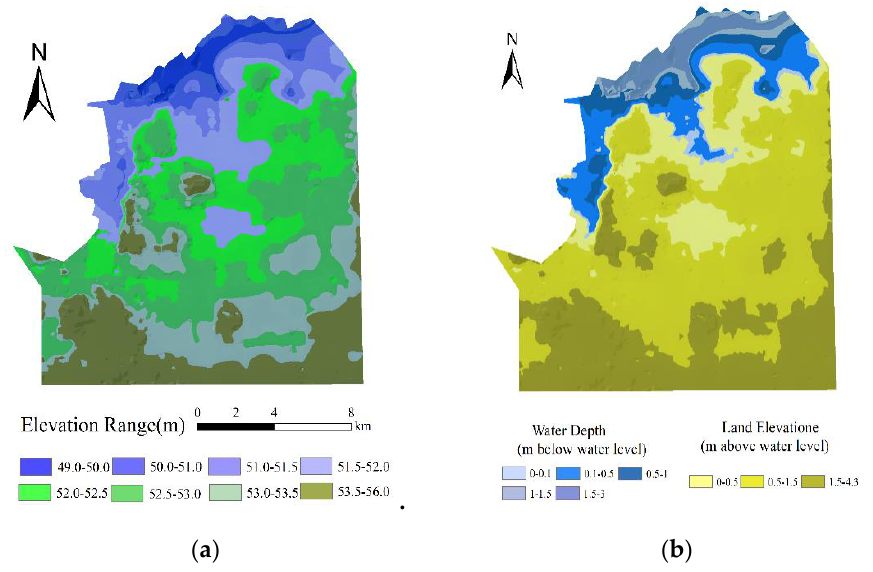
Figure 3. ( a ) Topographical elevation (m) and ( b ) elevation relative to the water level.